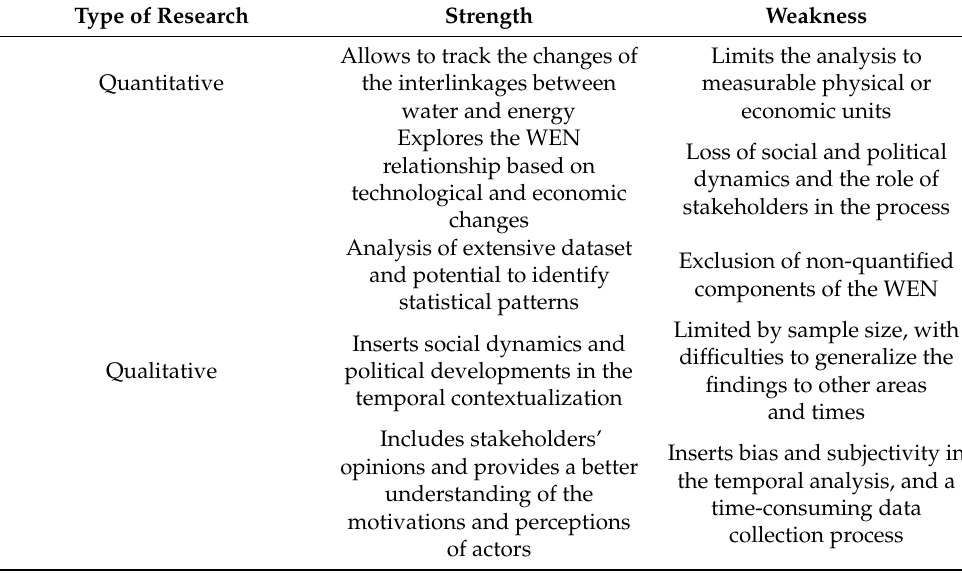
Table 4. Main strengths and weaknesses of qualitative and quantitative approaches for the temporal understanding of the